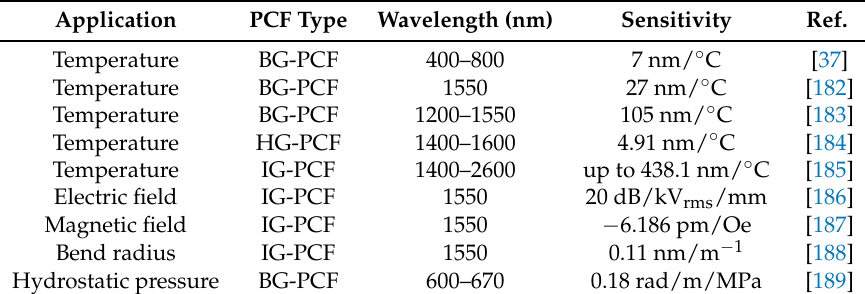
Table 3. Properties of most relevant liquid-crystal-infiltrated PCF